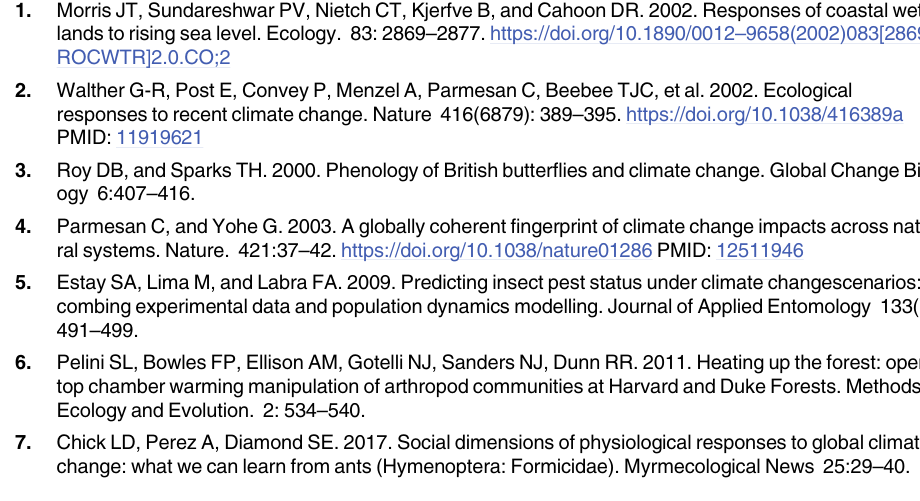
S8 Table. Size-standardized inland unpaired t-tests and Mann-Whitney tests. Vol/HW refers to mean relative value that results from dividing venom sac volume by head width and is reported in mm 2 . N represents the number of workers within the corresponding group, P is the p-value, and U is U-value from Mann-Whitney U tests. Tests that determined significant (p < 0.005) differences are marked by the word “yes” under the column labeled “different”.